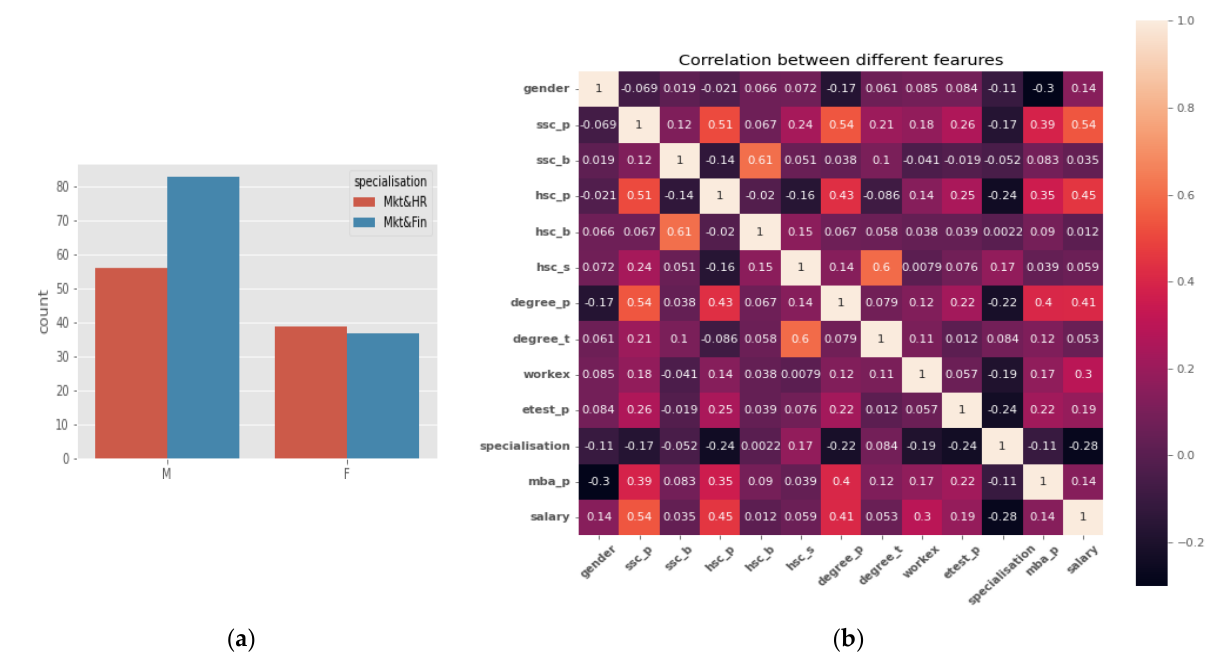
Figure 3. Data visualizations: ( a )the distribution of majors by gender ( b ) correlation matrix.